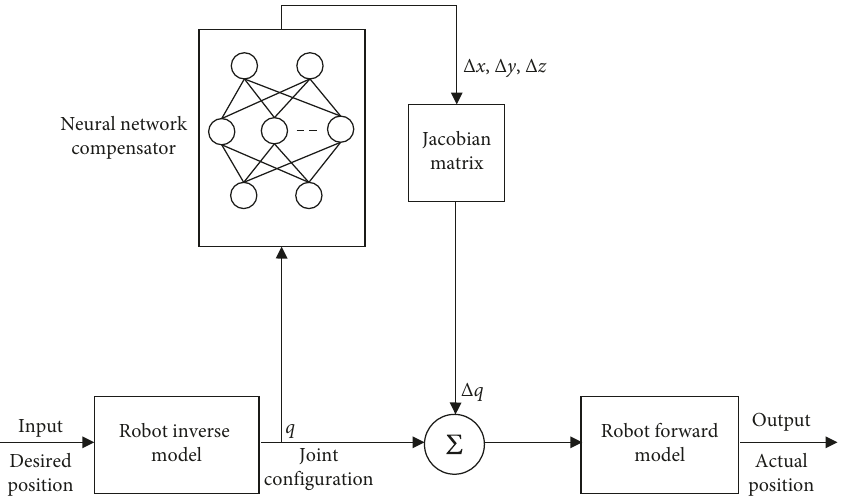
Figure 2: NN-based nongeometric errors